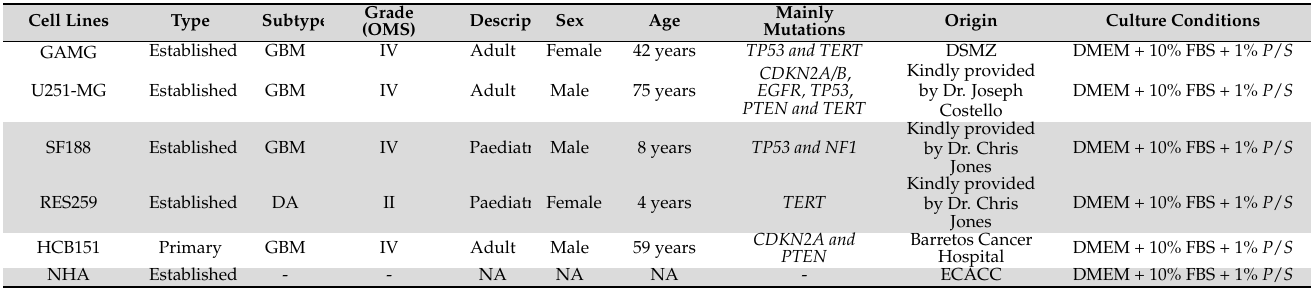
Table 7. Culture conditions and origin of the cell lines used.